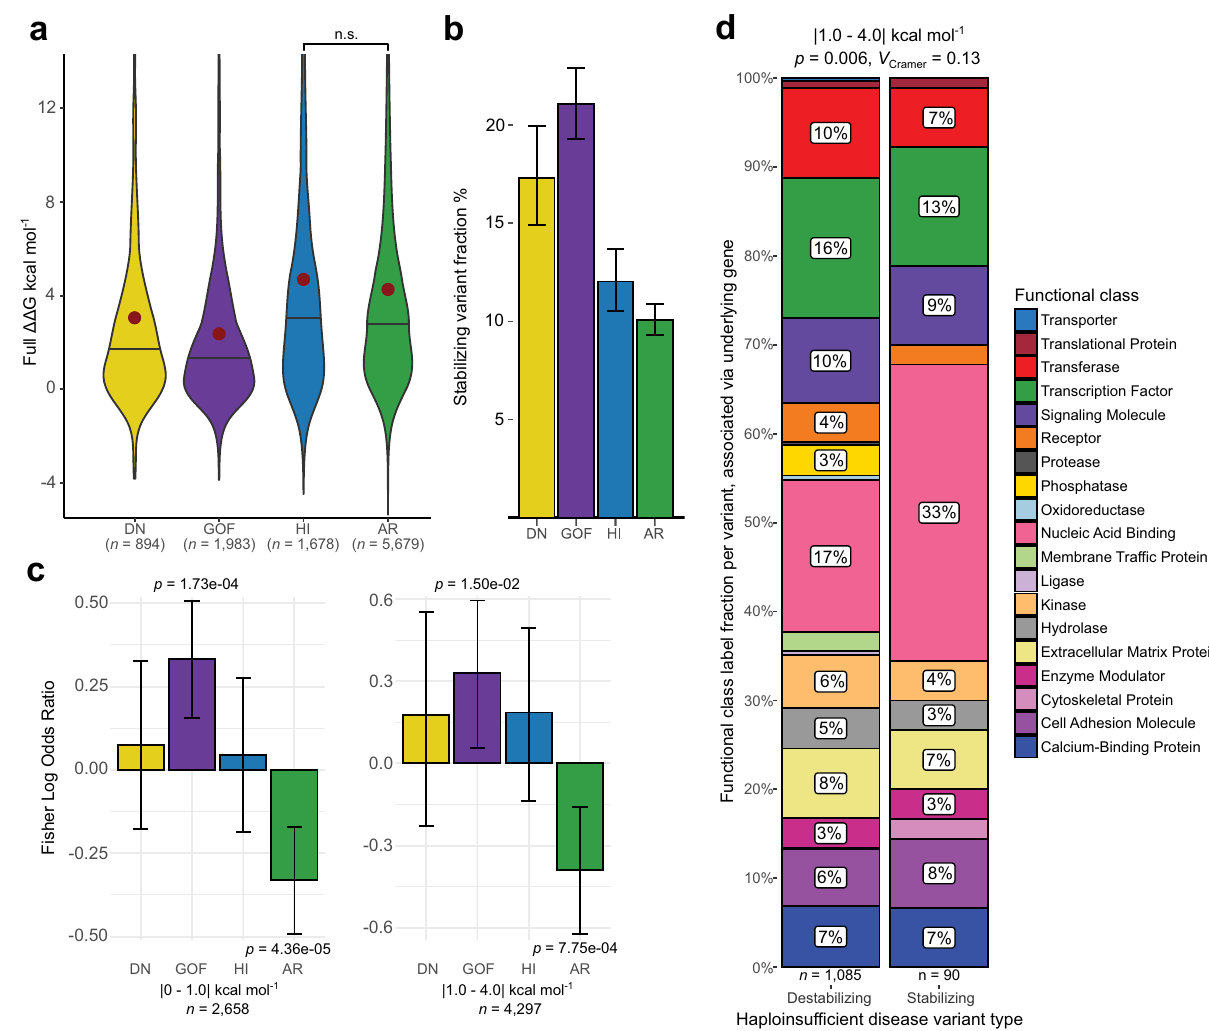
Fig. 4 Stabilising mutations may be important for disease in gain-of-function and particular functional class LOF contexts. a ΔΔ G distributions (not absolute values) for pathogenic mutations, associated with different molecular mechanisms. Violin middle line shows median, red dot represents the mean. Pairwise group comparisons are signi fi cant (p < 3.29 × 10 − 4 , two-sided Holm-corrected Dunn ’ s test) unless speci fi ed (n.s., p = 0.107). b Fraction of pathogenic mutations associated with different molecular mechanisms with negative (stabilising) ΔΔ G values. Error bars denote 95% con fi dence intervals. c Fisher log odds enrichments of stabilising mutations within each class from among all disease mutations. Error bars represent 95% con fi dence intervals. d Destabilising and stabilising variant prevalence differences in HI genes associated with particular functional classes. Sample sizes denote variant number, found in a gene associated with the particular function. Chi-square test p -value and effect size are shown. Source data are provided as a Source Data fi